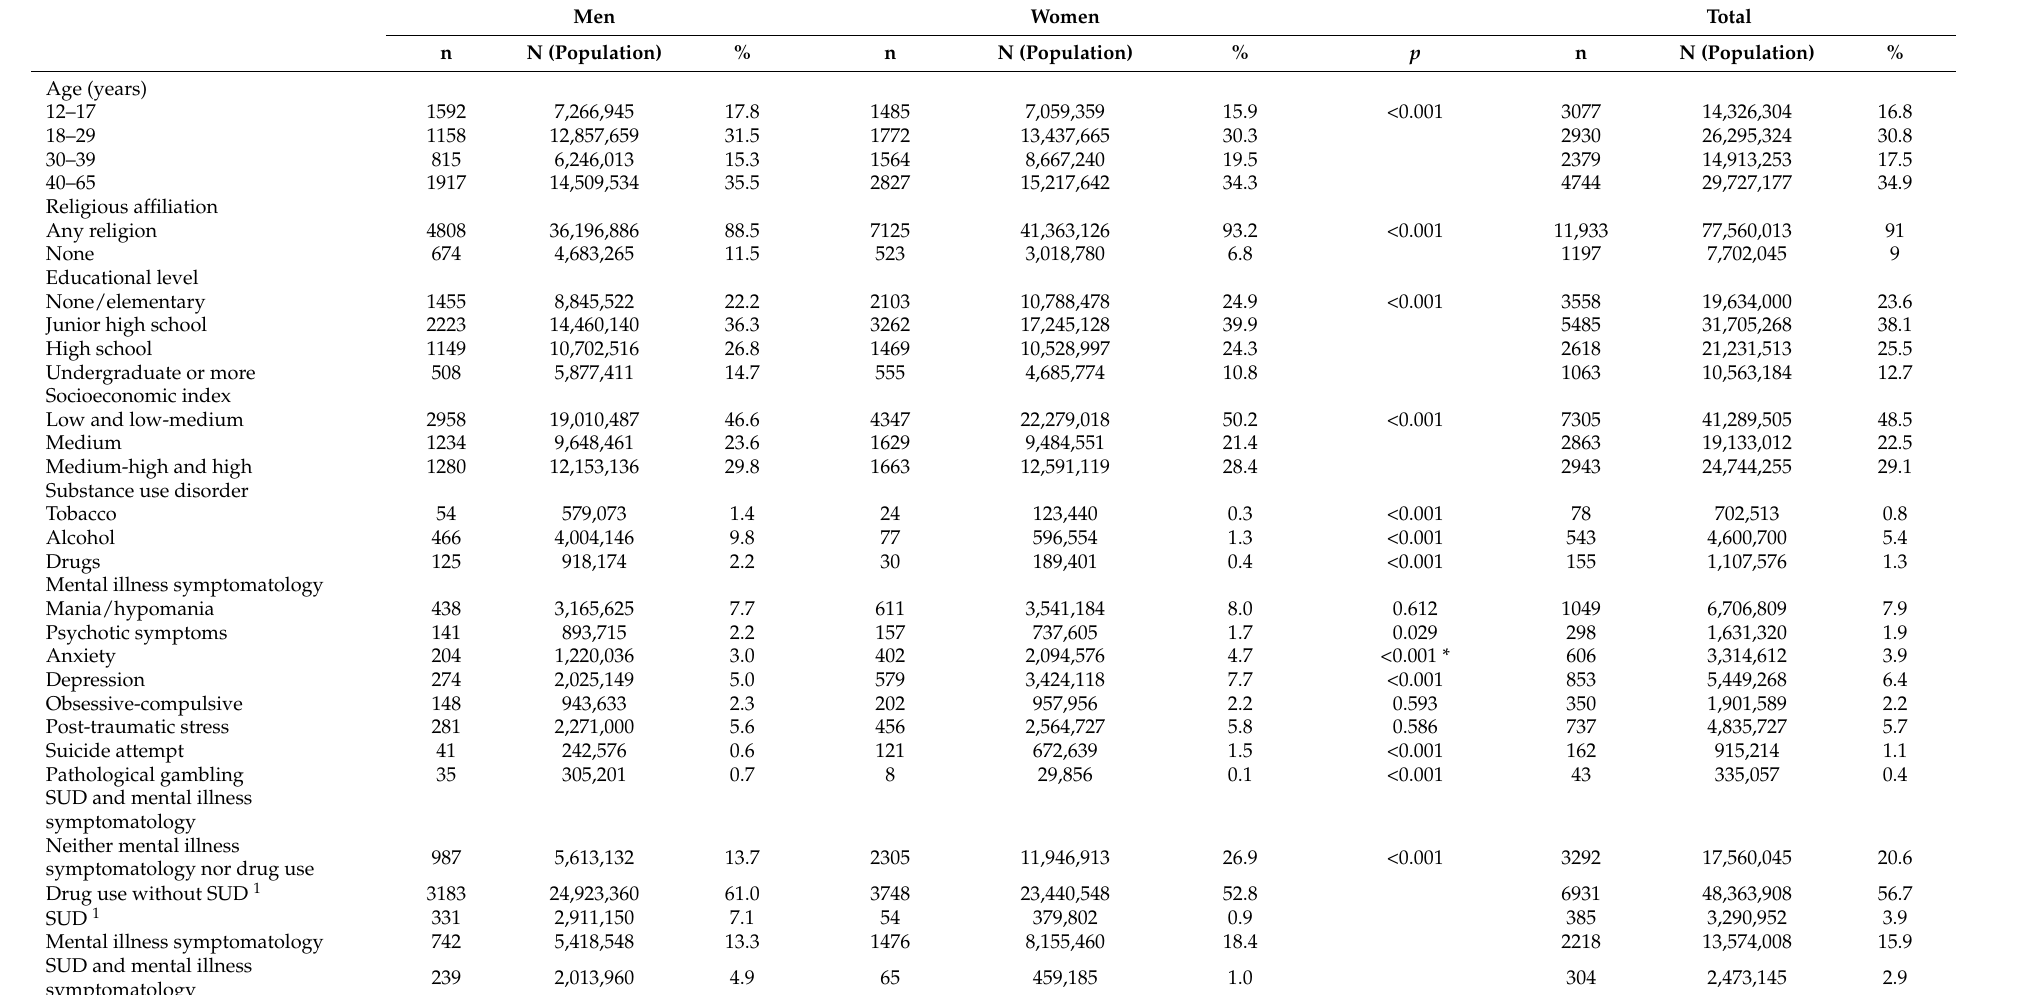
Table 1. Sociodemographic characteristics of the Mexican population aged